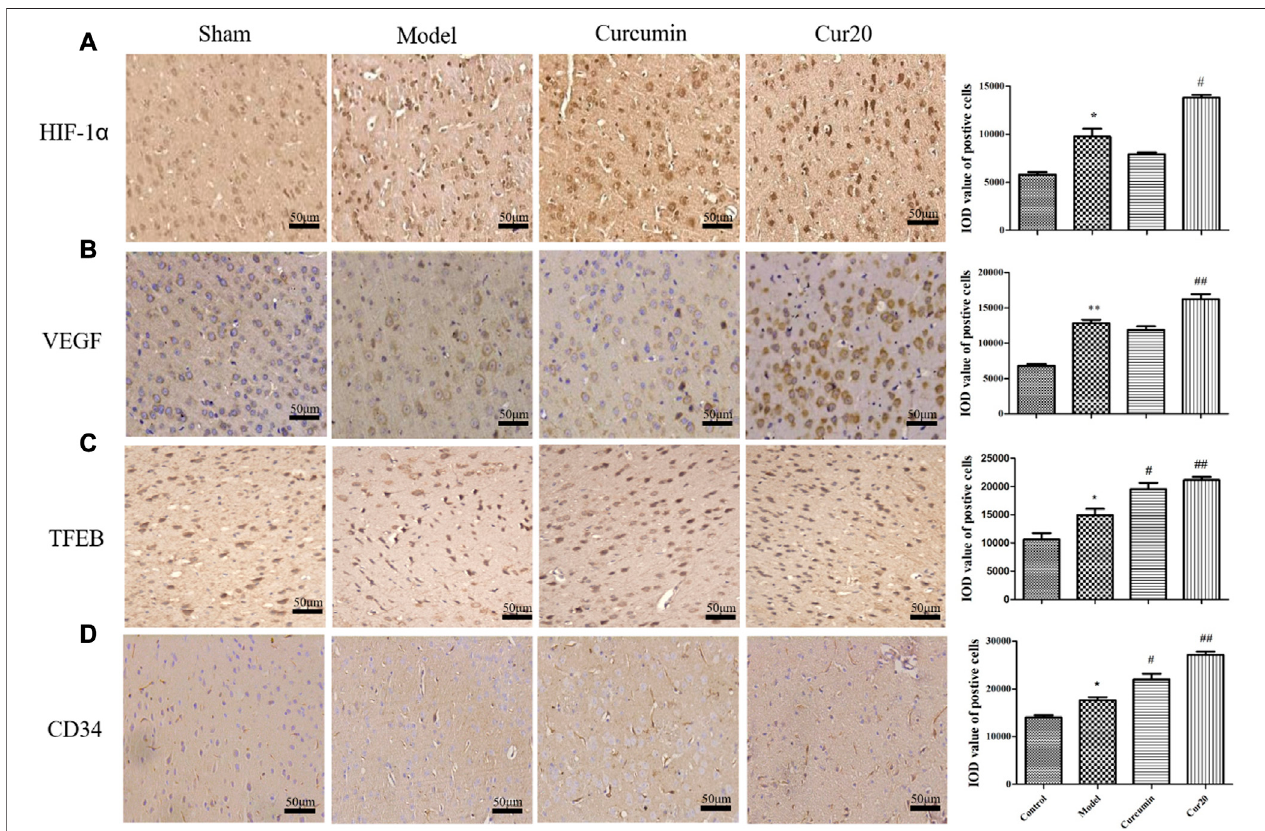
FIGURE 6 | Expression of HIF-1 a (A) , VEGF (B) , TFEB (C) , and CD34 (D) in cerebral cortex analyzed by immunohistochemistry. * p < 0.05 vs. sham group, ** p < 0.01 vs. sham group; # p < 0.05 vs. Model group, ## p < 0.01 vs. Model